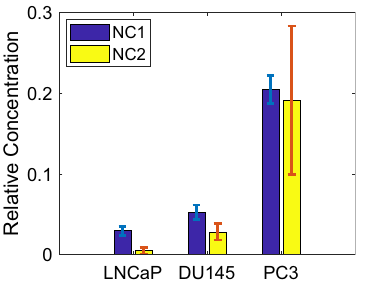
Figure 7. Relative concentrations of tryptophan and NADH/Lactate in three types of cells based on NC